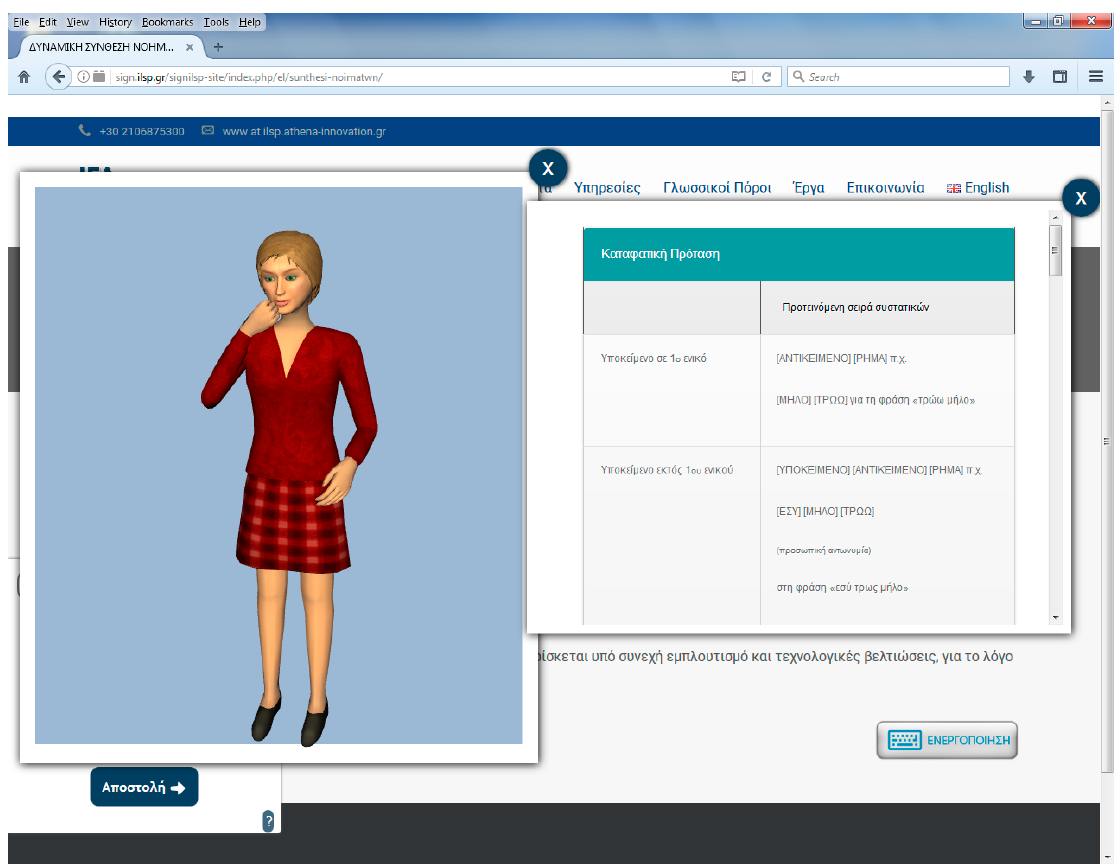
Figure 12. Dynamic building and presentation of synthetic phrases via a signing avatar. The box on the right provides GSL syntax instructions for phrase building.